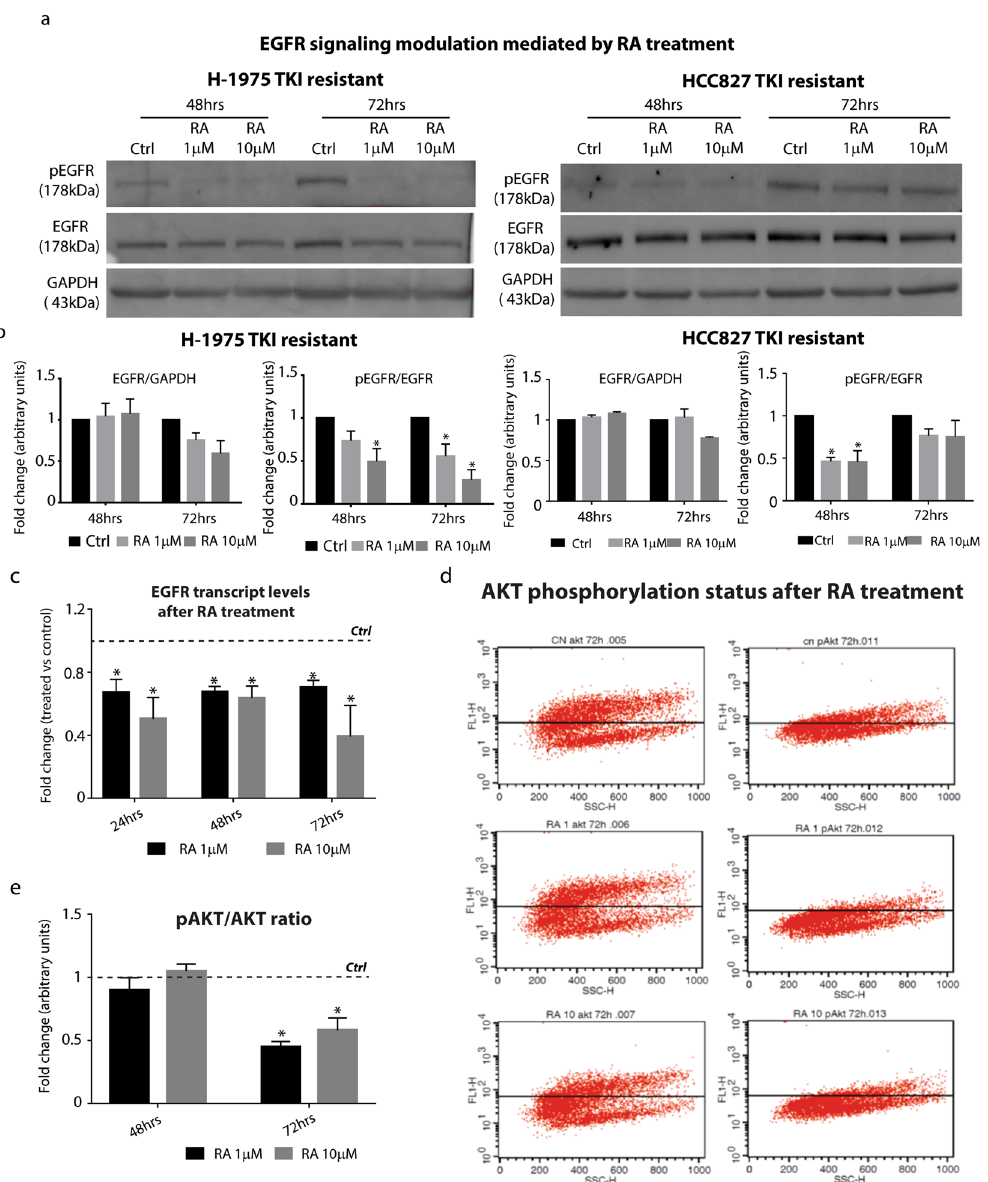
Figure 3. RA affects EGFR signaling activation in TKI resistant NSCLC cell line. (a) Representative Western Blotting analysis of EGFR and pEGFR in H-1975 and HCC827R1 cells treated with 1 and 10 µ M RA for 48 and 72 hrs (n = 3). (b) Densitometric analysis of EGFR and pEGFR protein levels in H-1975 (left panel) and HCC827R1 (right panel) NSCLC cell lines upon RA treatment for 48 and 72 hrs. The analysis has been performed by using GAPDH as normalizer loading control (n = 3) ( * = 0.02). (c) qRT-PCR analysis of EGFR H-1975 NSCLC cells treated with 1 and 10 µ M RA for 24, 48 and 72 hrs. The comparison has been conducted by using the ΔΔ CT method and normalized to GAPDH transcript. Dotted line represents the normalized expression levels of each transcript analyzed in untreated cells. Data are represented as mean ± SD. Statistical analysis has been obtained by unpaired t test (n = 3) ( * = 0.02). (d) Representative FACS plot representing AKT and pAKT levels in H-1975 cells treated with RA for 72 hrs (n = 3). (e) Quantification analysis of pAKT levels in H-1975 cells treated with RA for 48 and 72 hrs (n = 3) ( * =